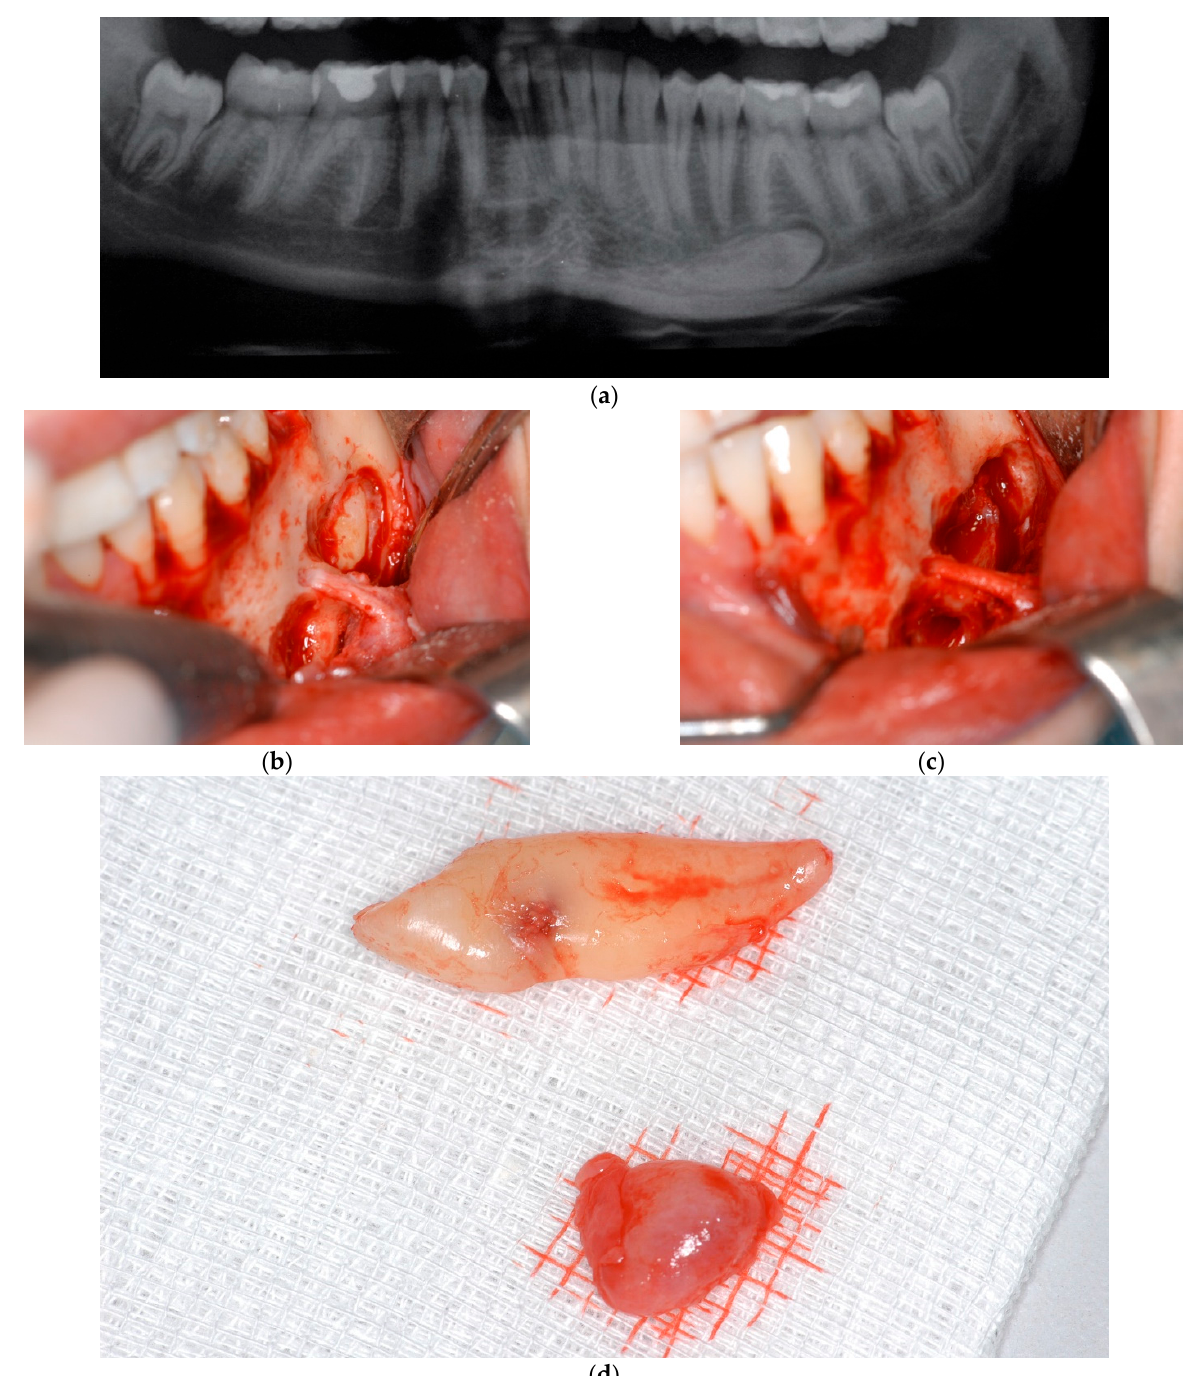
Figure 5. Transmigrated canine type IV. ( a ): Panoramic radiograph; ( b ): canine with a close relation- ship with mental nerve; ( c ): canine extraction with mental nerve preservation; ( d ): canine with the follicular sac.